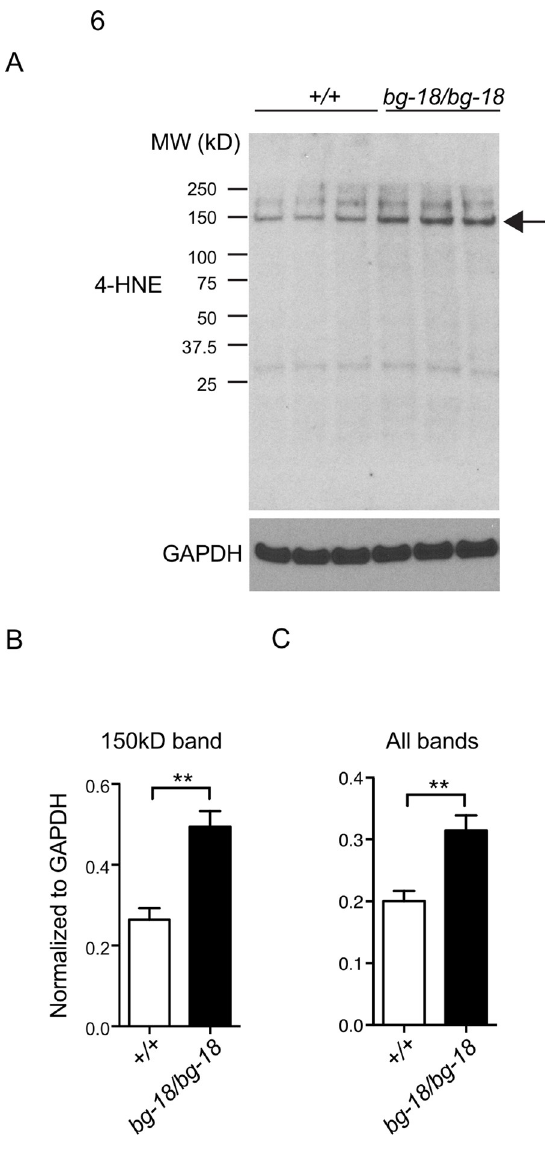
(A, arrow), and all bands including the 150 kDa band are quantified,